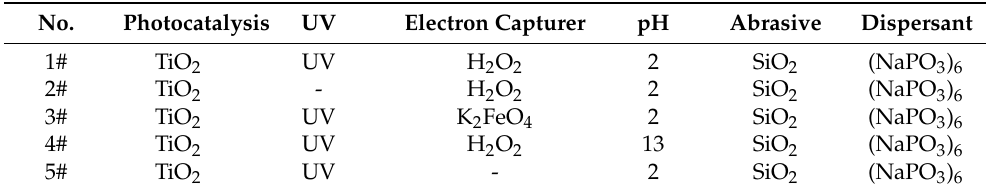
Figure 11. Surface roughness and material removal rate of SiC polished by different slurries [14] . Table 1. Different slurries for PCMP of 4H-SiC [14].